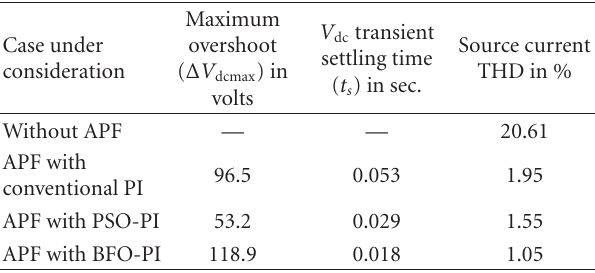
Table 2: APF response comparison under ideal supply